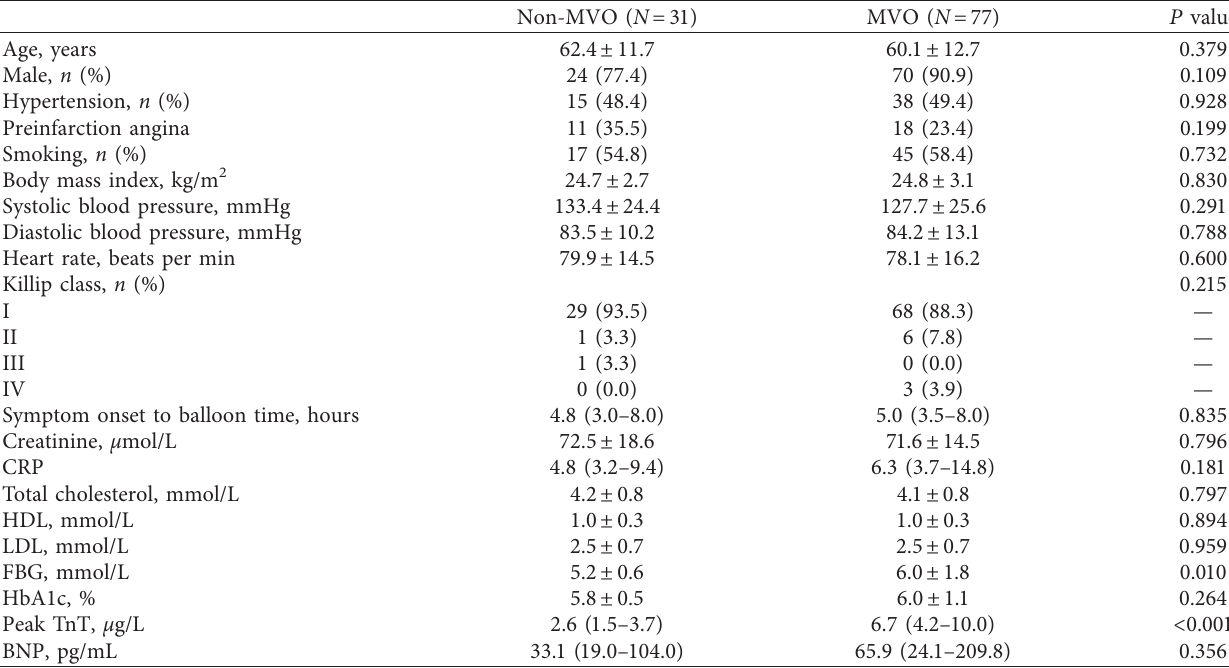
Table 1: Baseline clinical characteristics of the participants.